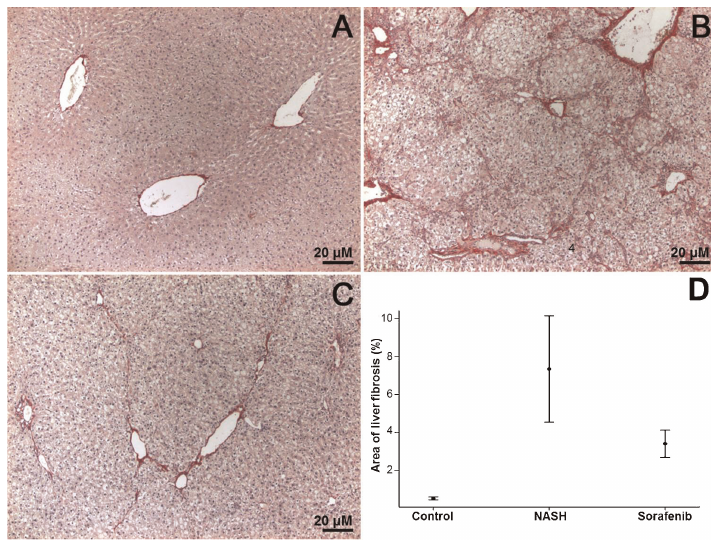
Figure 1. Analysis of liver extracellular matrix by morphometry of collagen fibers stained in red with Sirius Red. A , Control animal (n=4); B , nonalcoholic steatohepatitis (NASH) animal